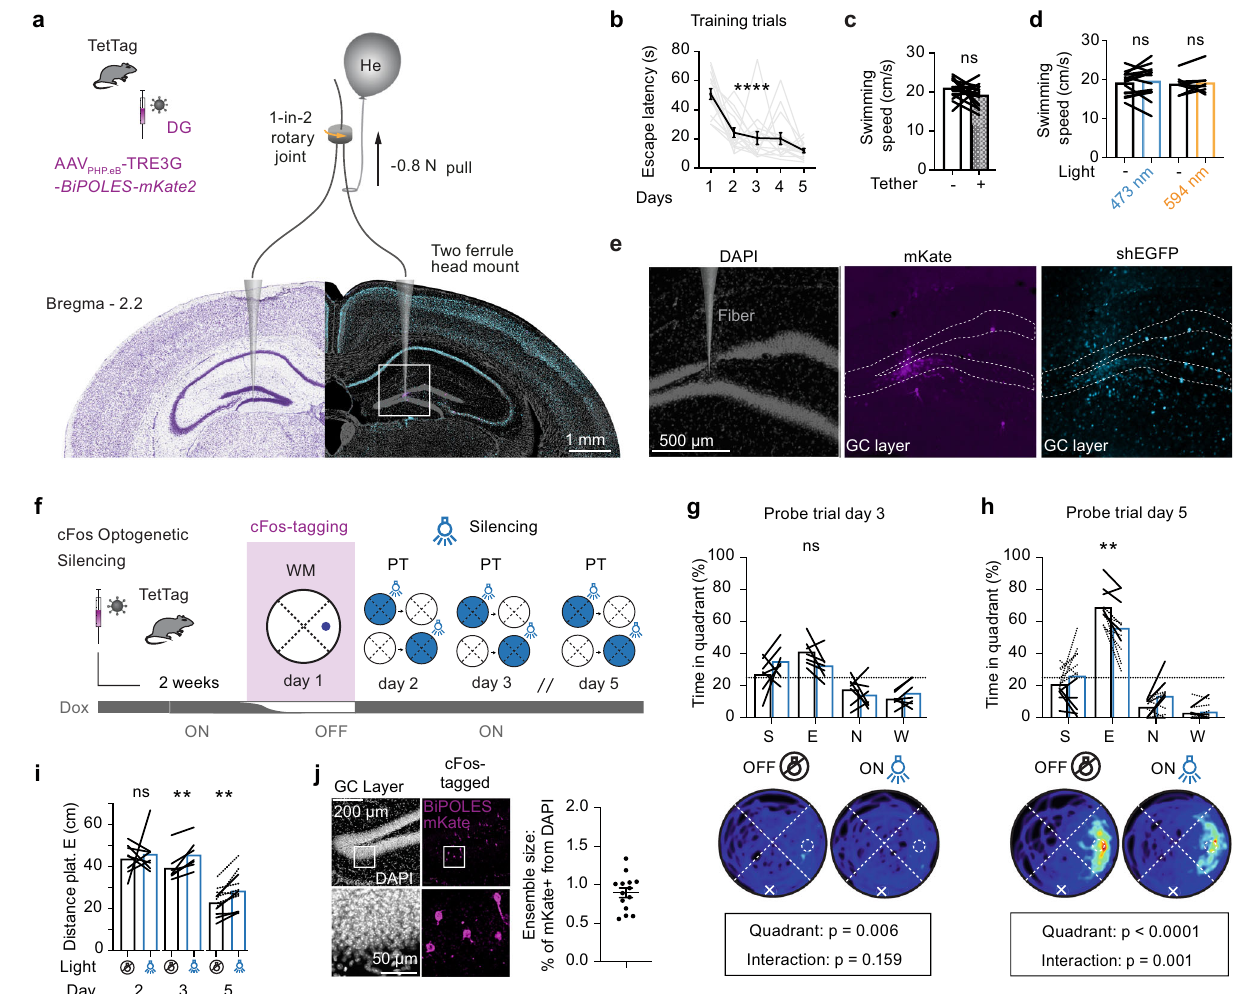
Fig. 3 | Optogenetic silencing of cFos-tagged granule cells impairs spatial memory recall. a TetTag mice were injected with AAV for cFos-dependent expression of BiPOLES and fl uorescent label (mKate2, magenta). Mice were bilat- erallytetheredwithultra-thinlight fi berstargetingthegranulecell(GC)layerofthe dentategyrus 70 . b Fibersandimplantdidnotaffectlearning(graylines: n =15mice; black: mean ±SEM; **** p <0.0001, ordinary one-way-ANOVA for repeated mea- sures). c Swimmingspeedoftetheredmicewithballoonswasnotdifferentfromthe same animals in untethered trials ( n =15 mice, p =0.12, two-sided paired t test). d Optogenetic inhibition (473nm) or excitation (596nm) did not affect swimming speed (473nm light, n =15 mice, p =0.53, two-sided paired t test) (594nm light, n =8 mice, p =0.74, paired t test). e Tapered fi ber caused minimal damage in DG. f On days 2, 3, and 5 of water maze training, the cFos-tagged ensemble from day 1 wasinhibited (blue shading) in one of two tethered probe trials. g On day 3,probe trialoptogeneticinhibitionhadnosigni fi canteffecton thetime spentinthe target